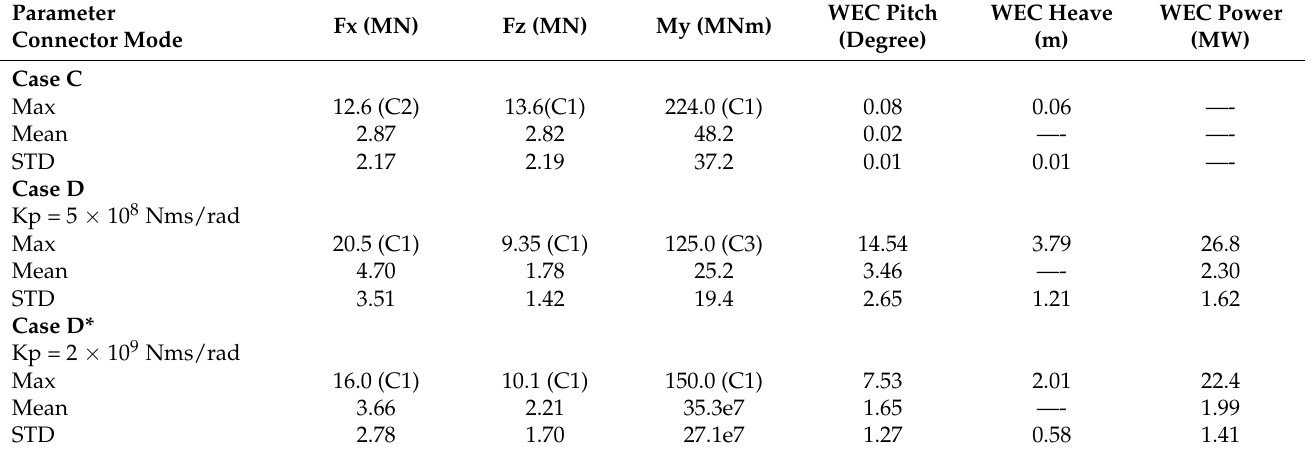
Table 3. Statistical information of main extreme responses of the seven-module MTLPW